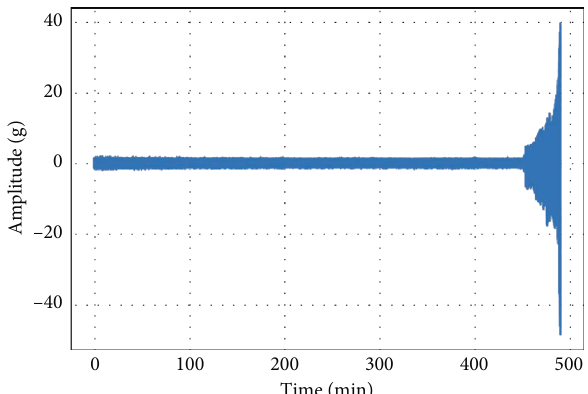
Figure 7: Vibration data of bearing2_1 dataset.